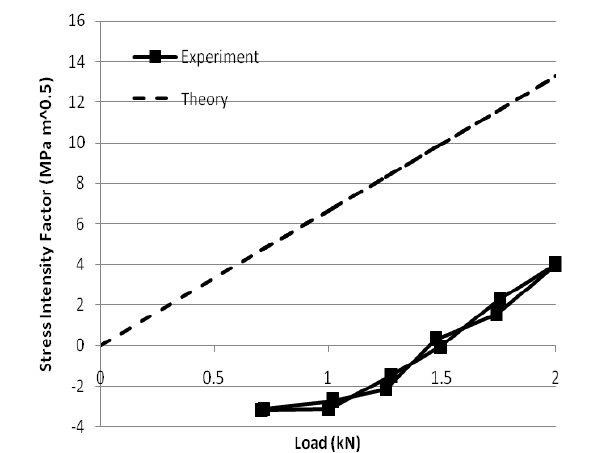
Figure 5: Variation of measured stress intensity factor with load for specimen CTF6, 23,500 cycles after the overload.